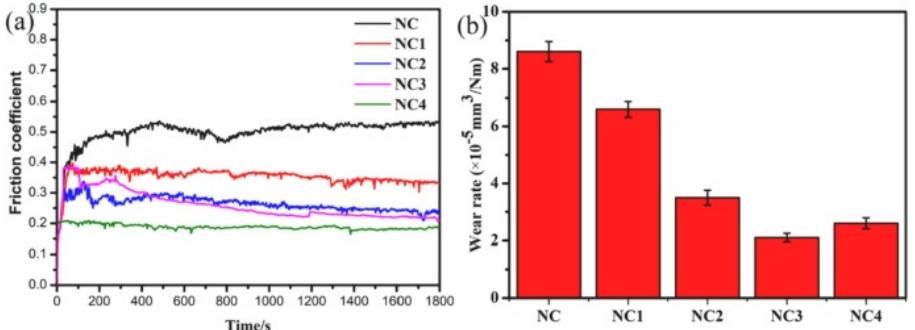
Figure 11. The variation of ( a ) friction coefficient, ( b ) wear rate for Ni–Cr–Mo-based composite containing TiO 2 /Bi 2 O 3 . Reproduced with permission from [87]. Copyright Elsevier, 2021. In summary, both binary and ternary oxides can provide superior tribological prop- erties at high temperatures. Among binary oxides, V 2 O 5 provides a low CoF and wear rate because of the low shear strength. A combination of metallic oxides can provide superior tribological properties at extremely HT. Table 3. Ceramic matrix-based self-lubricating composites and their HT behavior.